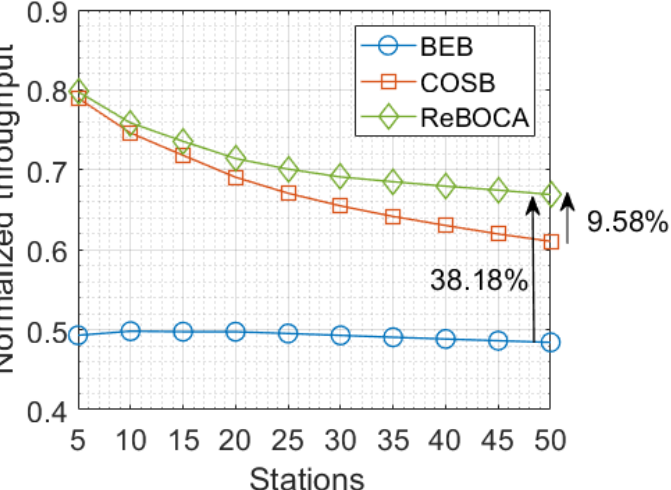
Figure 7. Comparison of normalized throughput among BEB, COSB, and ReBOCA due to change in network